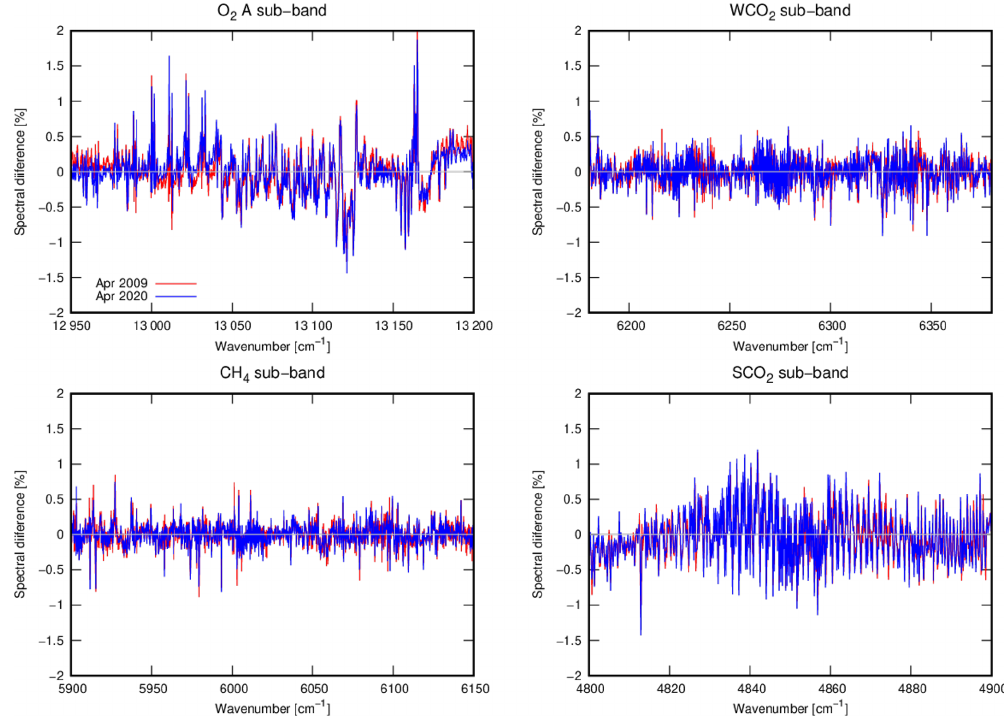
Figure 2. Same as Fig. 1, but for